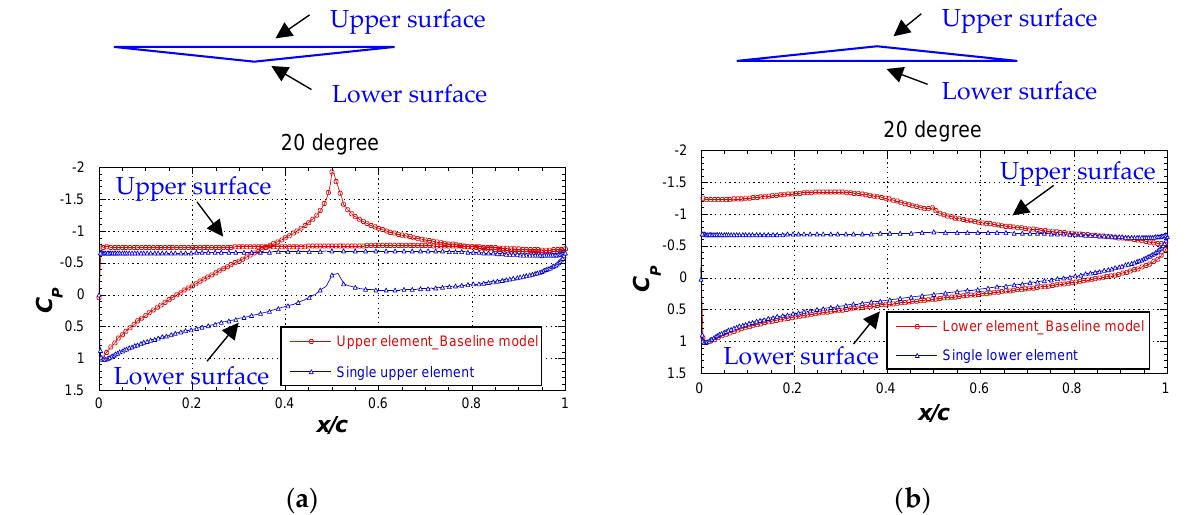
Figure A3. Comparison of pressure coefficient in airfoil surface of the wing elements as single configuration and baseline configuration (CFD results): ( a ) upper element; ( b ) lower element.